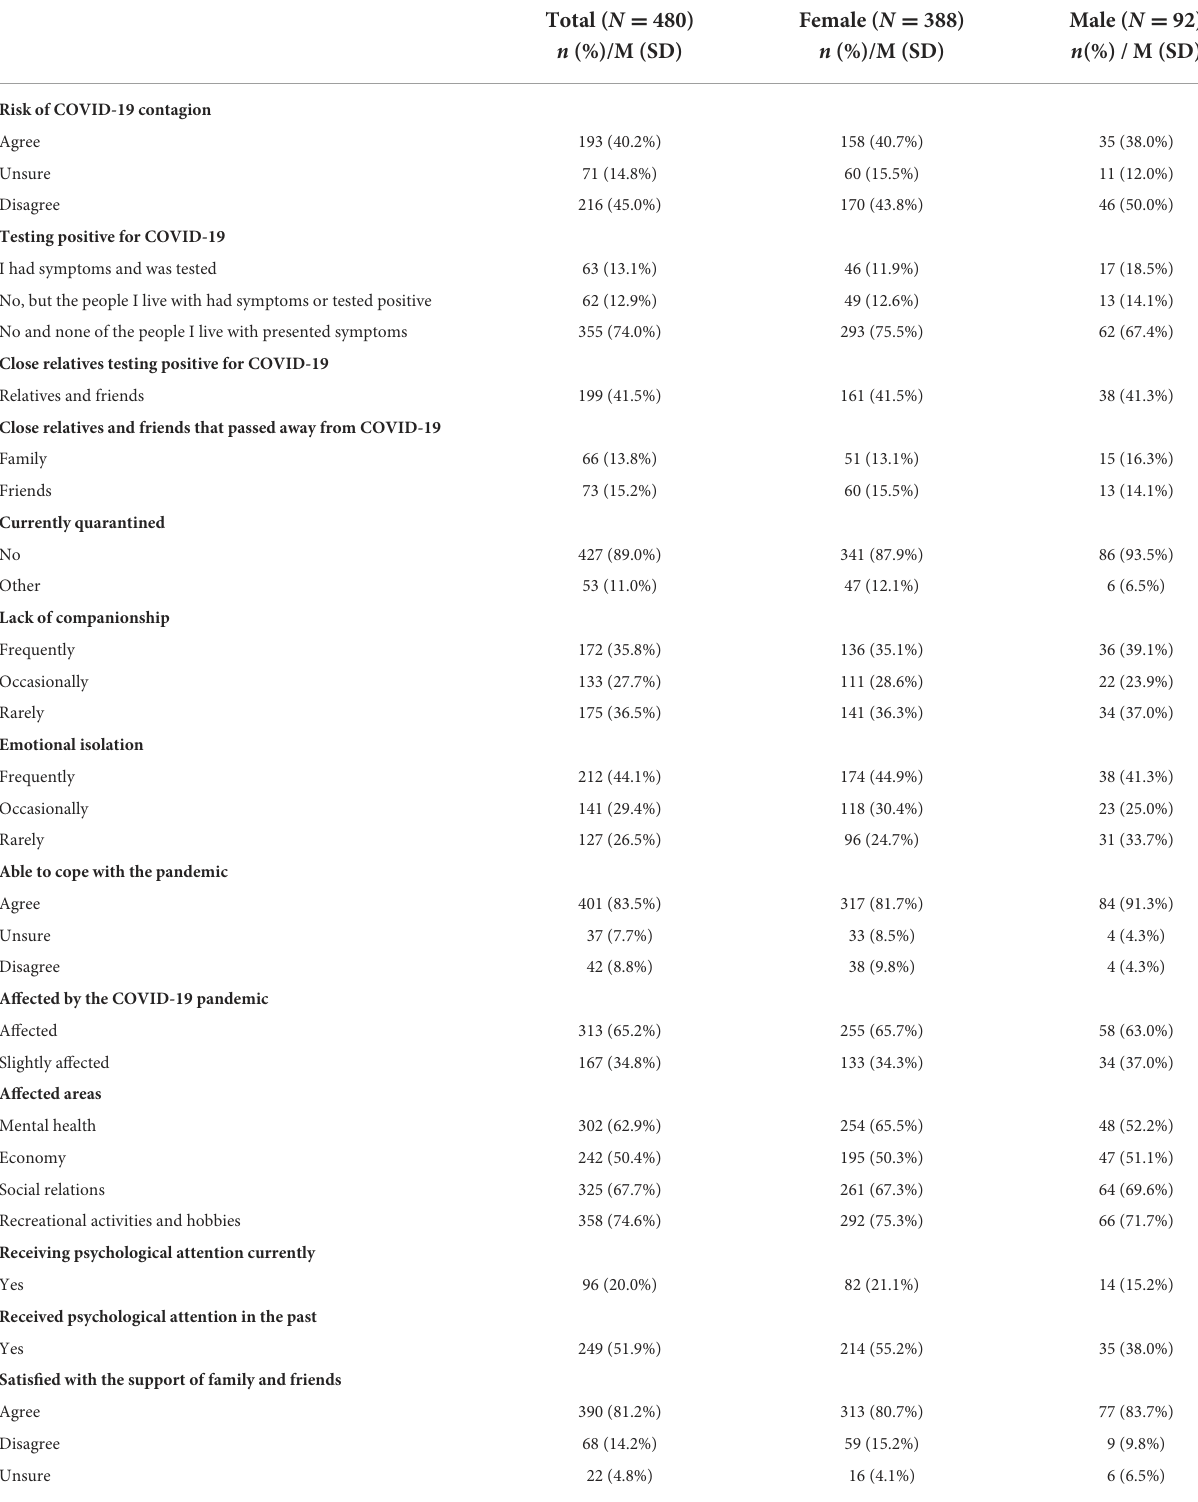
TABLE 3 Contagion risk, affected areas and psychological